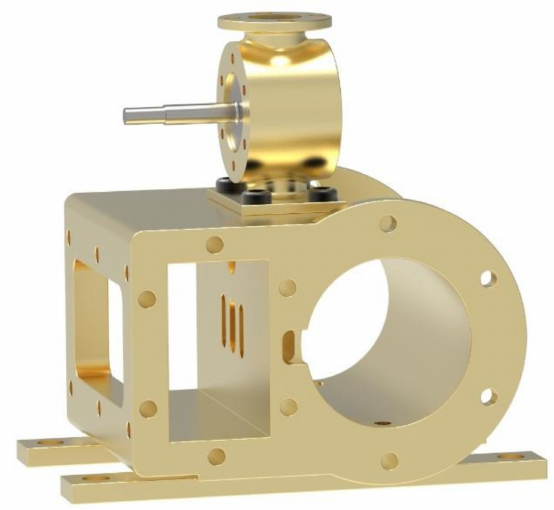
Figure 9. Steam chamber subassembly.